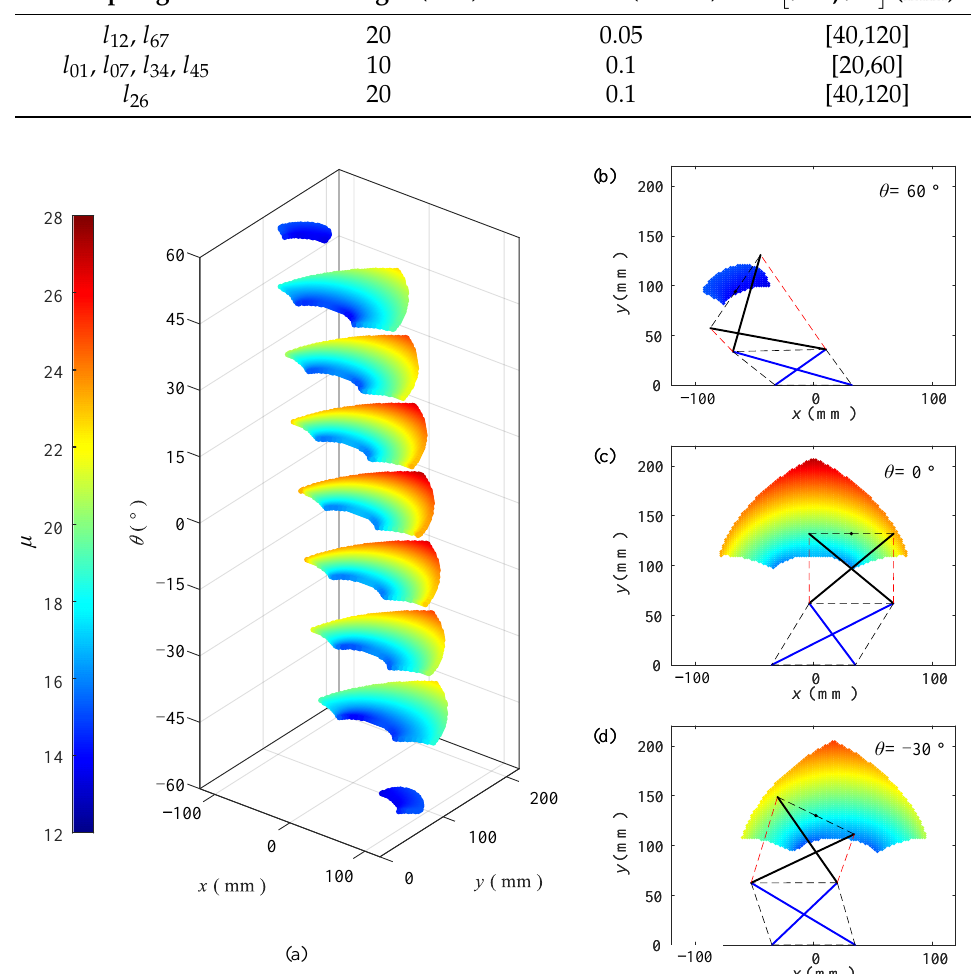
Figure 7. Workspace and manipulability.( a ) Isometric view. ( b ) θ = 60 ◦ . ( c ) θ = 0 ◦ . ( d ) θ = − 30 ◦